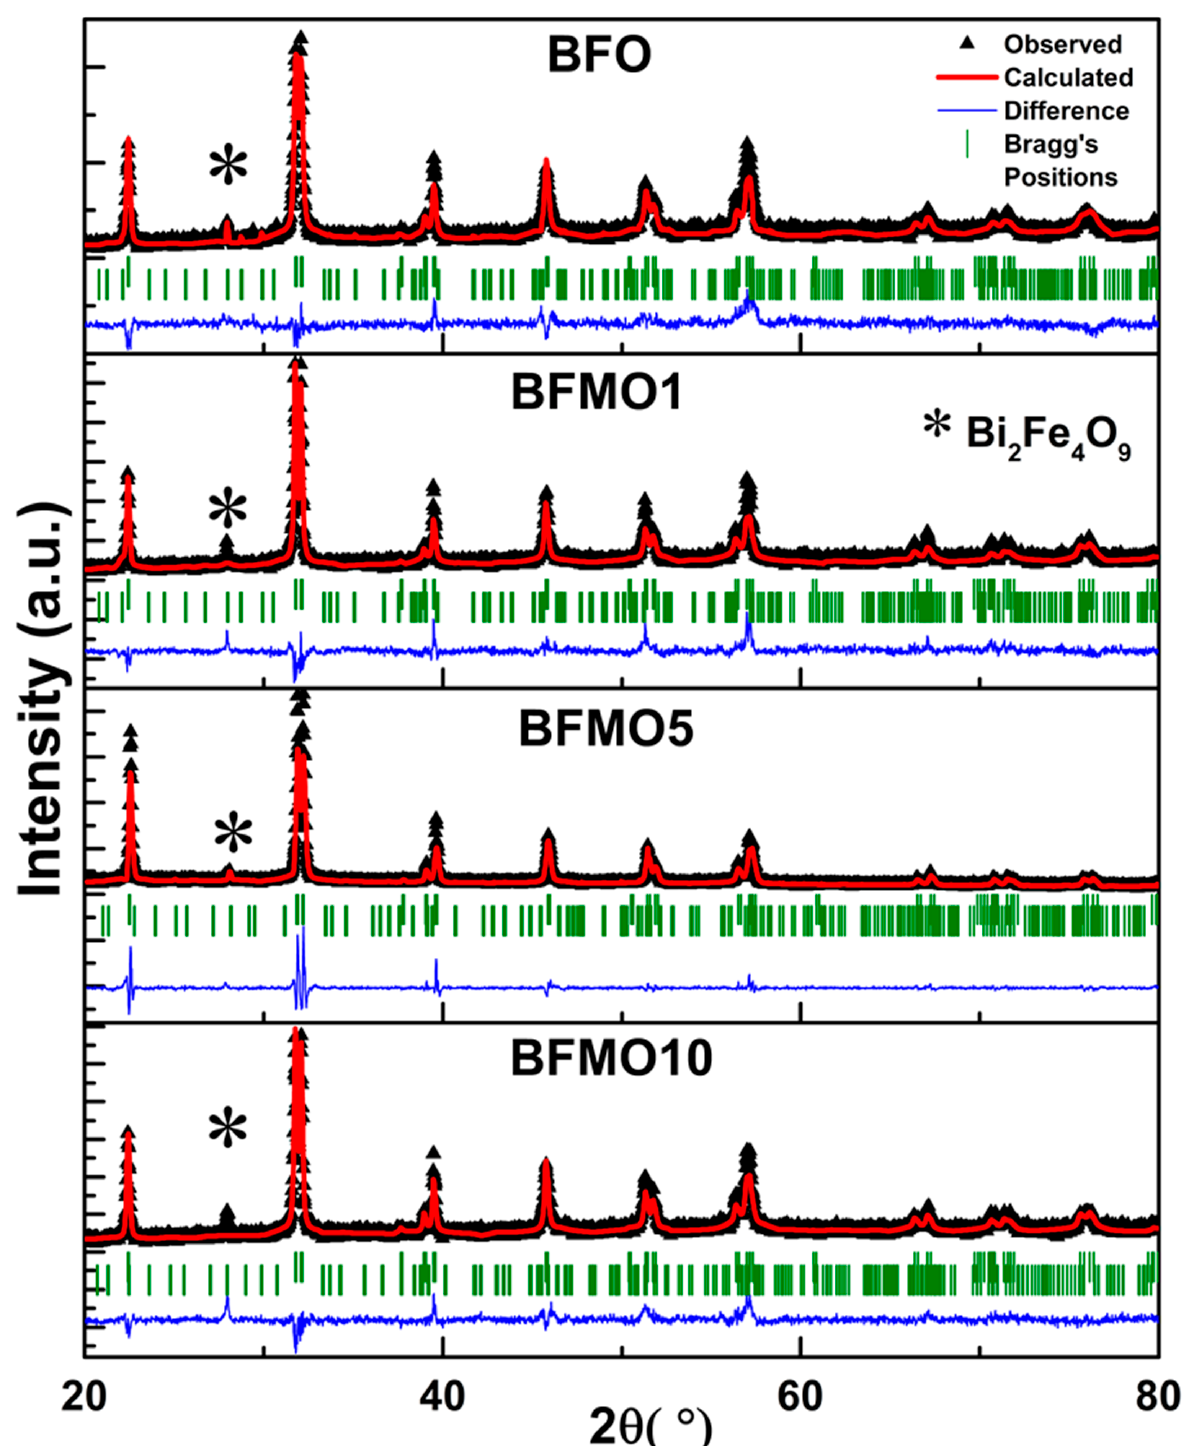
Figure 1. XRD patterns of BFO, BFMO1, BFMO5, and BFMO10 in the 2 θ range ( a ) 20–80°; ( b ) 27– 33°.